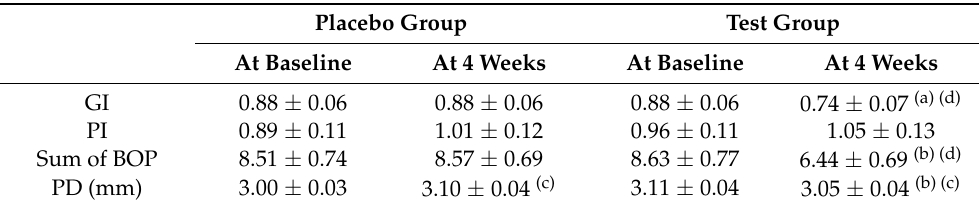
Table 2. Mean changes in gingival index (GI) scores, plaque index (PI), sum of bleeding on probing (BOP) and probing depth (PD) by groups. Data are presented as the mean ±